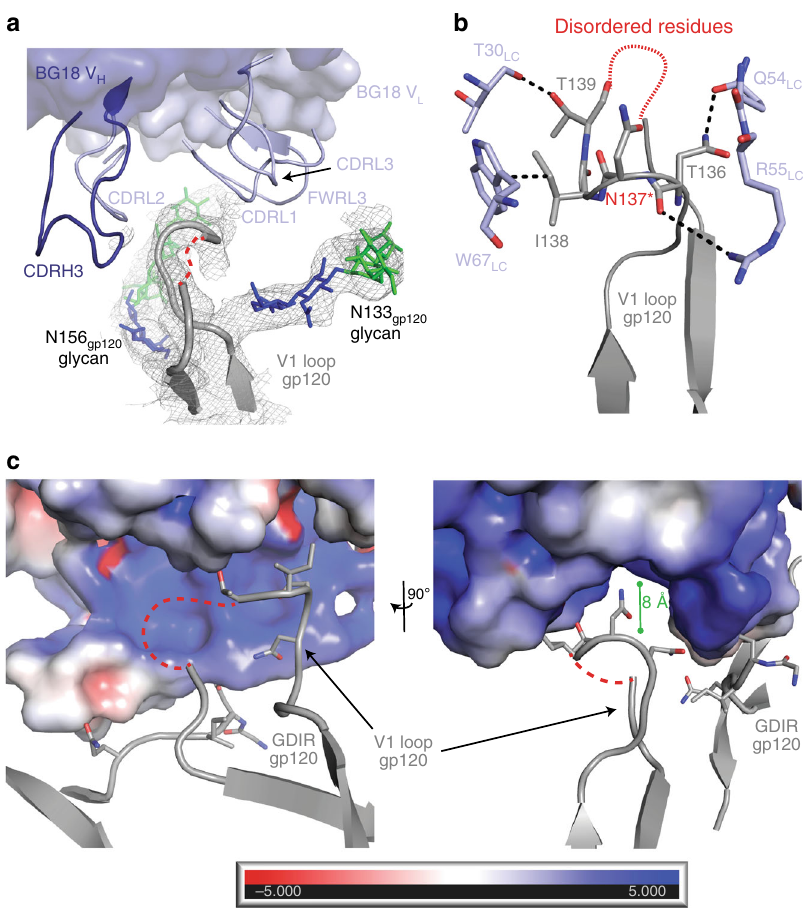
Fig. 6 BG18 contacts with gp120 V1-loop. a Surface and cartoon representation of BG18 V H (dark blue) and V L (light blue) loops involved in gp120 V1-loop (gray; residues 128 – 158, disordered residues depicted as dashed red line) interactions. Electron density contoured at 1 σ from a 2 F obs − F calc composite annealed omit map is shown (gray mesh). Glycans at position N133 gp120 and N156 gp120 are shown. b Cartoon and stick representation of residue interactions between BG18 V L domain (light blue) and the gp120 V1-loop (gray). Potential H-bonding occurs between T139 gp120 and BG18 T30 LC in the CDRL1 loop. In addition, BG18 W67 LC in FWRL3 stacks against I138 gp120 . BG18 contacts with gp120 positions 138 and 139 are likely speci fi c to Envs with V1 characteristics similar to BG505, since similar conformations were not observed in our BG18-B41 structure. H-bonds and pi -stacking are indicated by black dashed lines. Red asterisk on N137 gp120 indicates a PNGS. c Electrostatic surface potentials with red indicating negative electrostatic potential and blue indicating positive electrostatic potential for BG18 shown with cartoon and stick representation of nearby gp120 elements. BG18 includes a positively charged cleft in the vicinity of the gp120 V1-loop (dashed line indicates disordered region), which may provide increased protein – protein interactions with the gp120 surface in HIV-1 strains harboring charged residues in the